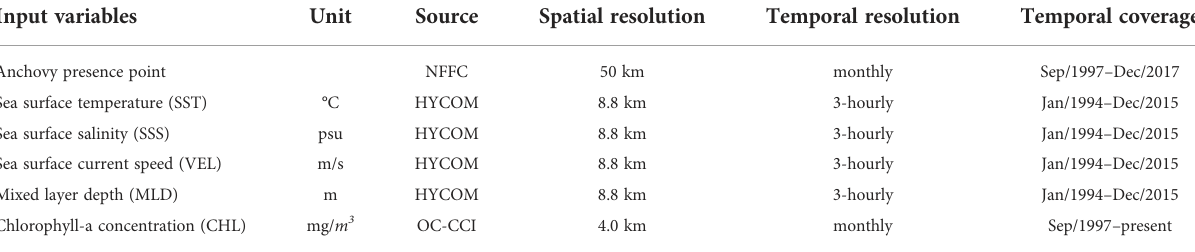
TABLE 1 The input dataset for the anchovy ( Engraulis japonicus ) MaxEnt construction. Input